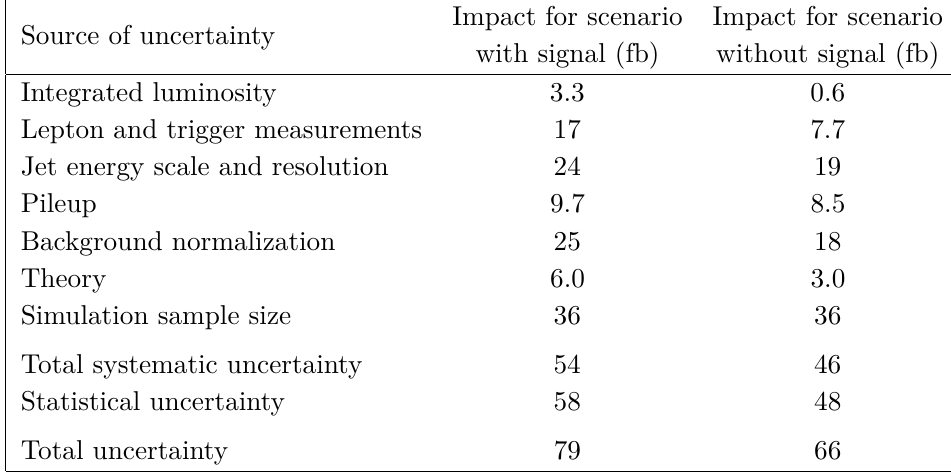
Table 3 . Summary of the uncertainties in the fitted signal cross section in fb for m assuming the presence of a signal ( σ = 0 . 05 σ